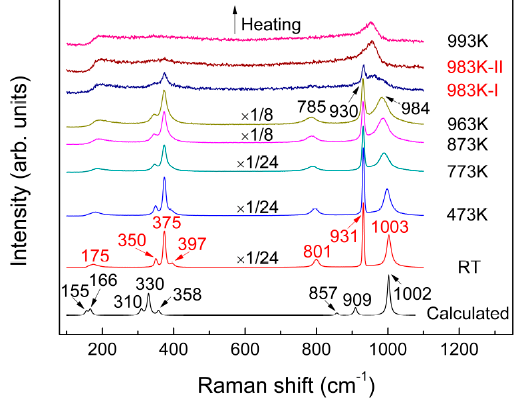
Figure 3. Temperature-dependent Raman spectra of KAl(MoO 4 ) 2 recorded from RT to 993 K and the room temperature spectrum calculated by the Cambridge Sequential Total Energy Package (CASTEP).